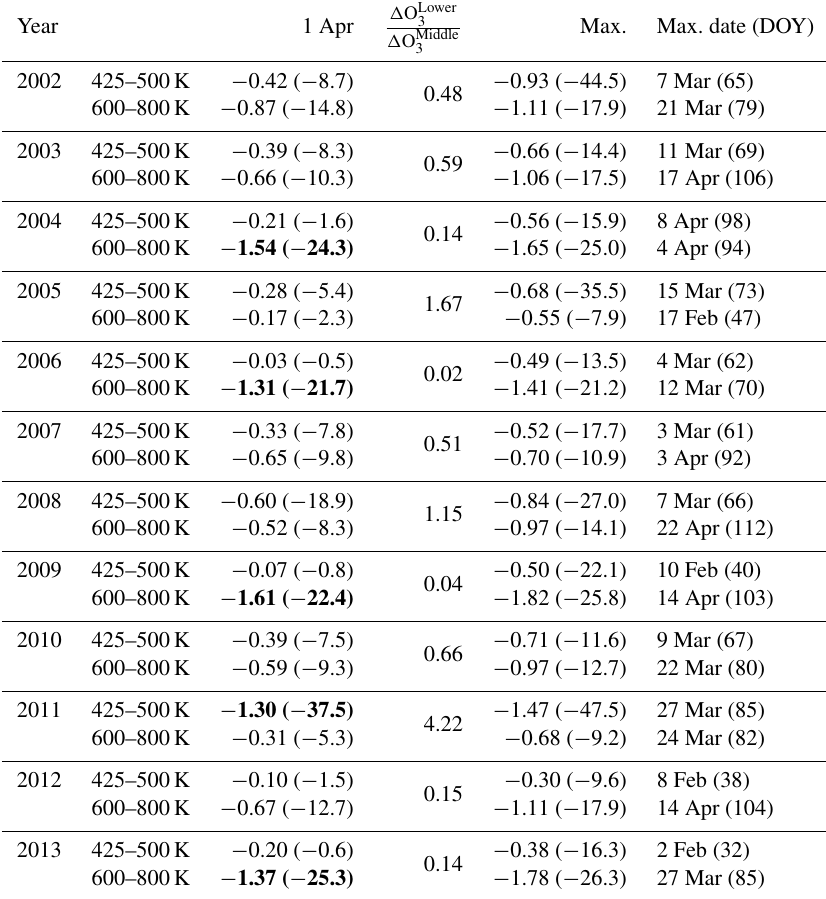
Table 1. Accumulated ozone loss in the Arctic vortex (EQL, 70–90 ◦ N) on 1 April (day of year (DOY) 90 or 91), ratio of the average loss in the lower stratosphere (425–500K) to the average loss in the middle stratosphere (600–800K) and value of the maximum loss and the corresponding date, for each year between 2002 and 2013. All O 3 losses are given in VMR (ppmv). The values lower than − 1ppmv on 1 April are in bold. The column ozone change in Dobson unit (DU) is also given in